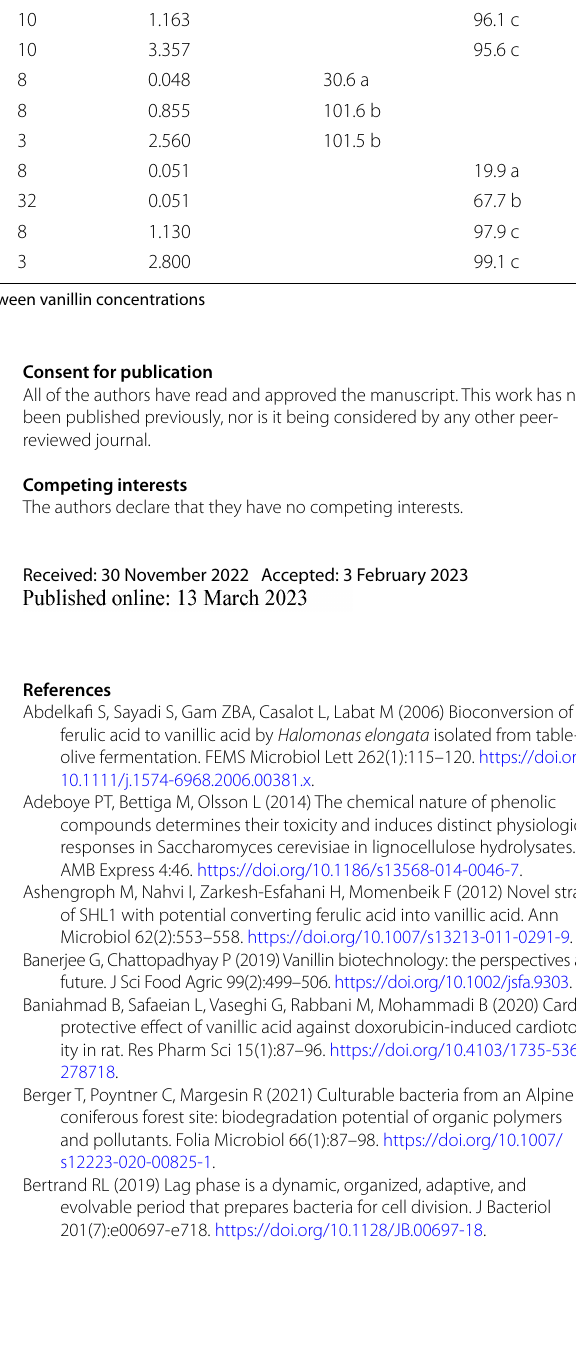
Table 6 VA production from 5 mM vanillin in the absence or presence of 5 mM FA and nutrient supplements by P. aromaticivorans AR20-38 at 10 °C and 20 °C. Data represent mean values of three replicates Vanillin (mM)